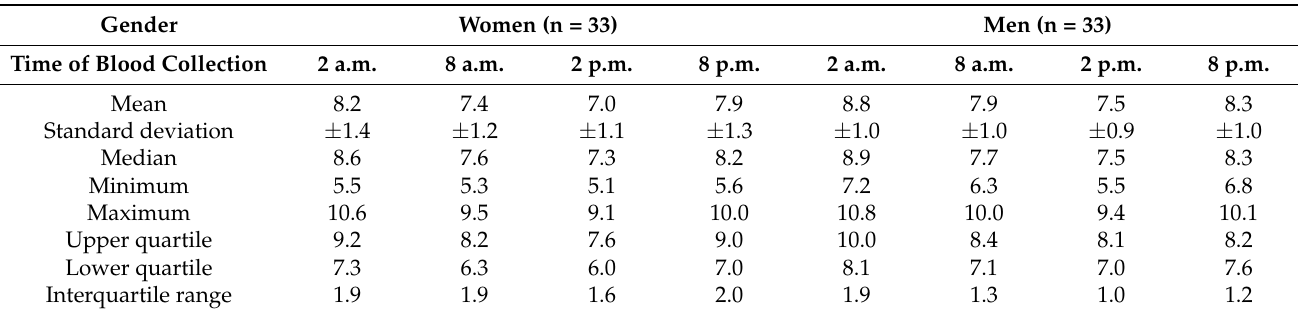
Figure 3. Average erythrocytes activity of CAT in men and women at different sampling time points. Data presented as mean ± 95% confidence interval. MANOVA-type analysis ( p = 0.93485). 2.5. Analysis of the Influence of Circadian Rhythm on the Activity of Glutathione Peroxidase Table 5. Parameters describing glutathione peroxidase (GPx) activity in women and men, including the time of blood collection (U/g